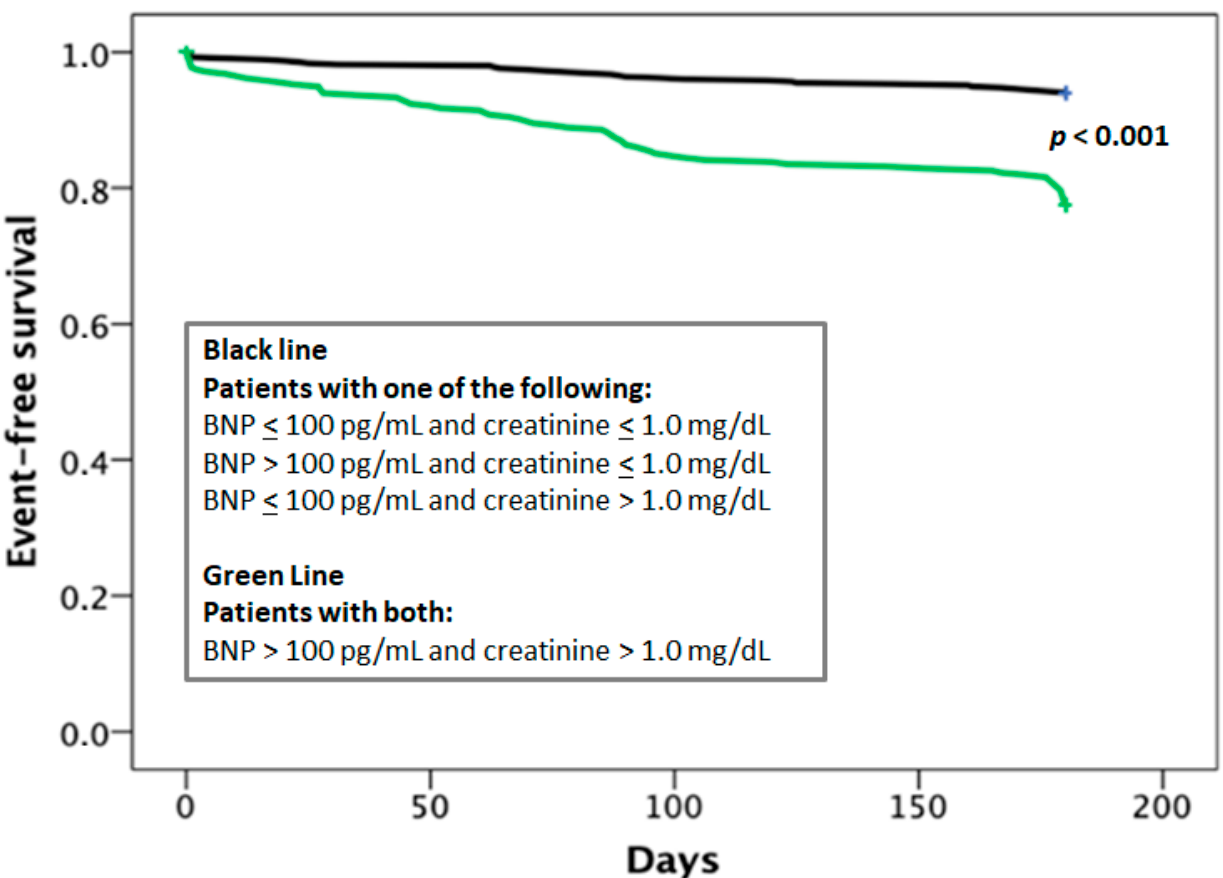
Figure 1. Kaplan–Meier curves comparing the occurrence of events in relation to combined BNP and creatinine cut-off levels.